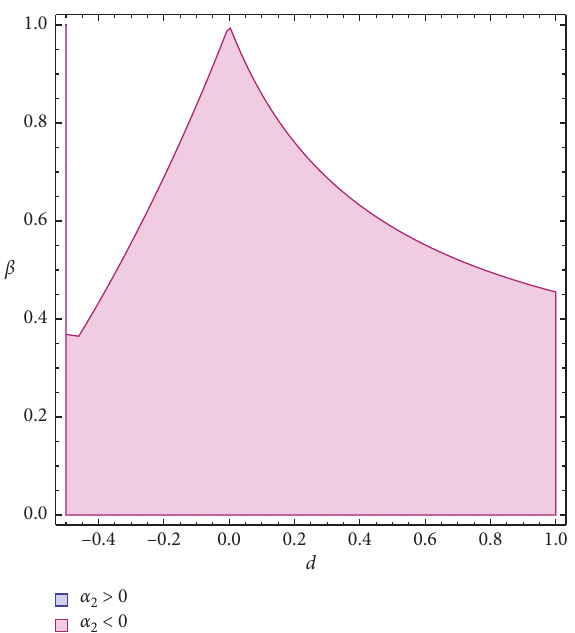
Figure 1: The region diagram where the sign of α